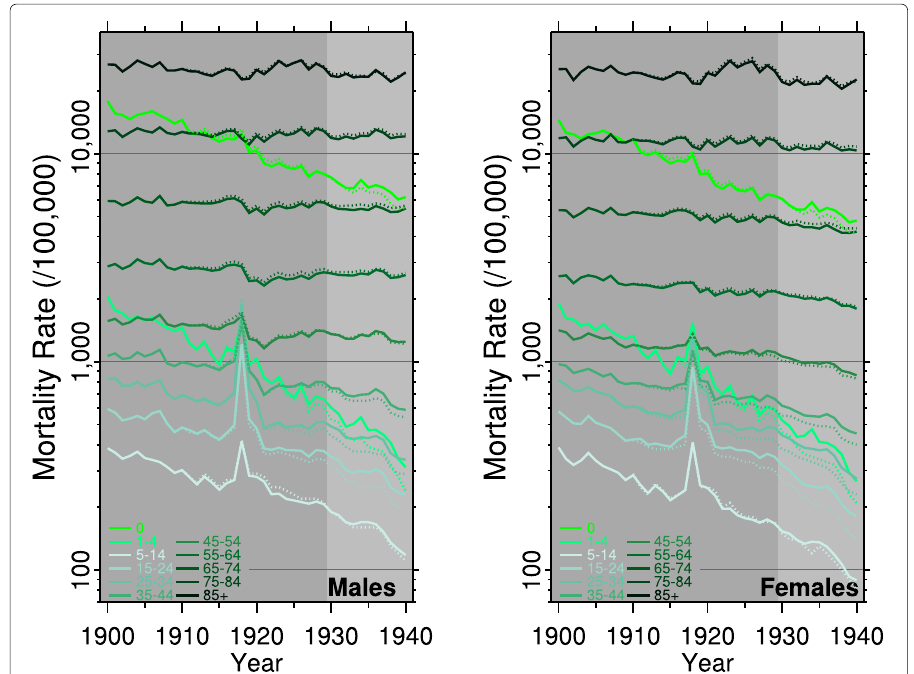
Fig. 5 Mortality rates by age, 1900–1940, all races. Solid lines are for the death registration area (1900–1932) and USA (1933–1940); dotted lines are for the death registration states of 1910 (1910–1940). Darker shading denotes input data to Lee-Carter model (up to 1929), but note that 1918 is excluded from the input